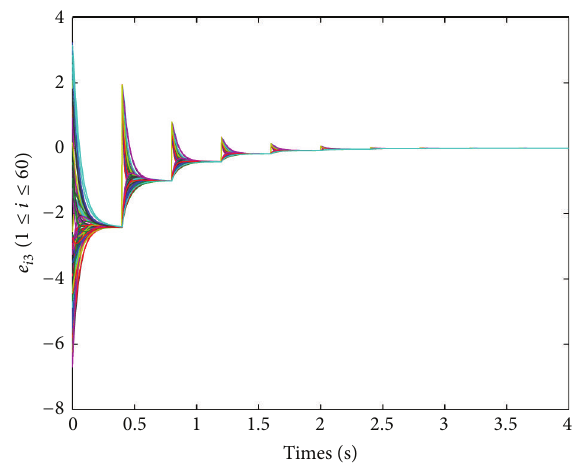
Figure 7: Rhythmic errors 𝑒 𝑖3 in BA